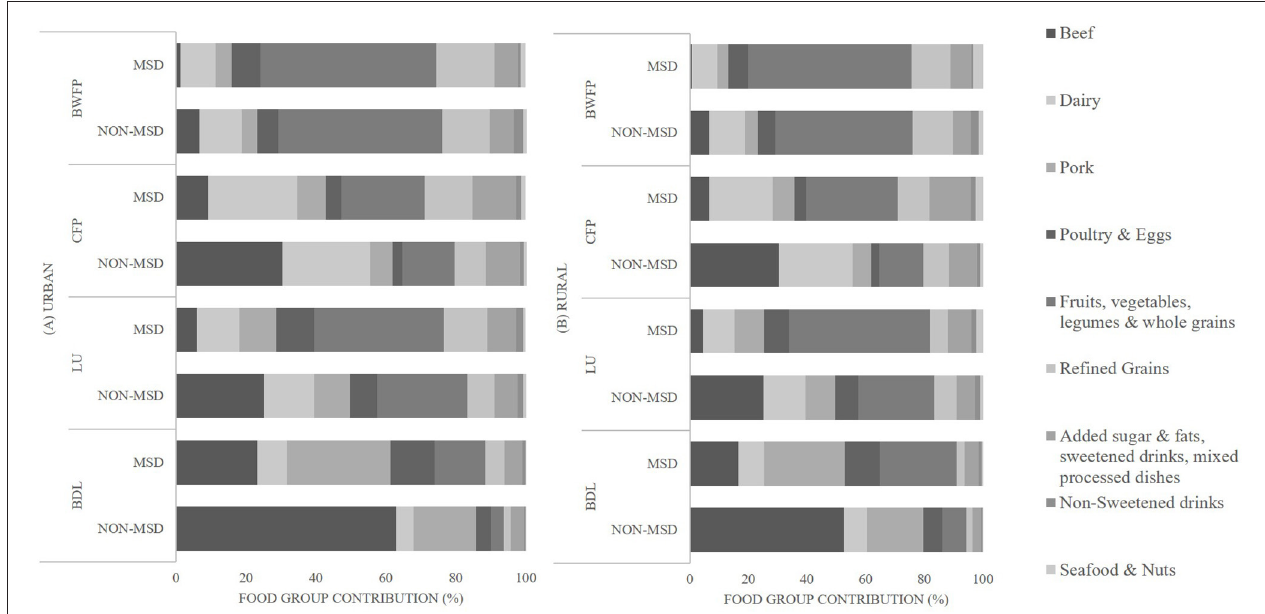
FIGURE 2 | Contribution (%) of food groups to the total environmental footprint indicators among adults with MSD and non-MSD in (A) urban and (B) rural areas of Mexico. BDL, Biodiversity loss (potential number of species lost/2,000 kcal × 10 − 10 ); LU, land use (m 2 /2,000 kcal); CFP, carbon footprint (kgCO 2 eq/2,000 kcal); BWFP, blue water footprint (L/2,000 kcal); MSD, more sustainable diet (diets with HEI-2015 above the median, diet cost and environmental indicators (land use, biodiversity loss, blue water and carbon footprint) below the median of the overall diet.